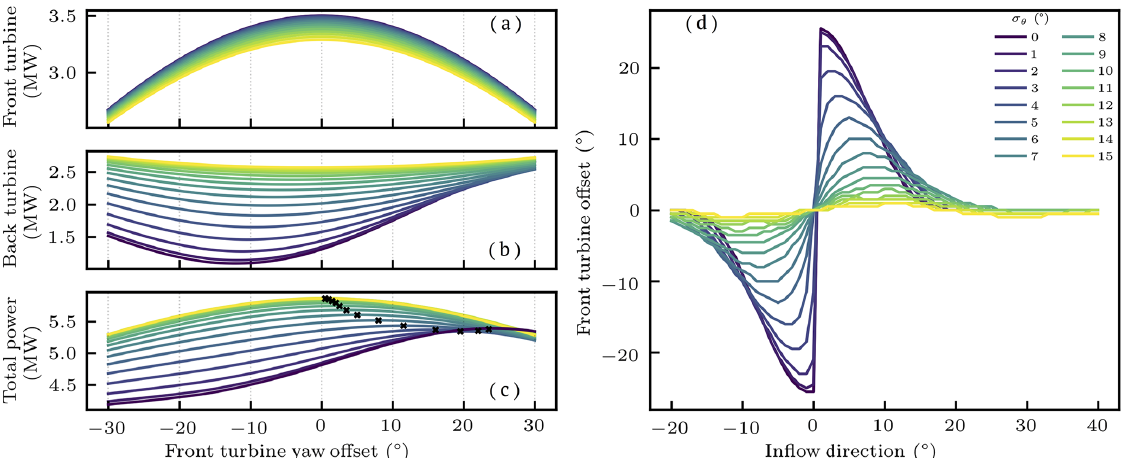
Figure 6. Power production for the front (a) , back (b) , and both (c) turbines as a function of front turbine yaw offset in the two-turbine case with 10ms − 1 inflow 3 ◦ from north. Different line colors indicate different values of σ θ , as indicated in panel (d) , with brighter colors corresponding to larger σ θ and, hence, greater uncertainty in inflow direction. The black crosses in panel (c) denote optimal front turbine yaw settings. Panel (d) shows the optimal front turbine yaw offset as a function of inflow direction for 7ms − 1 inflow.